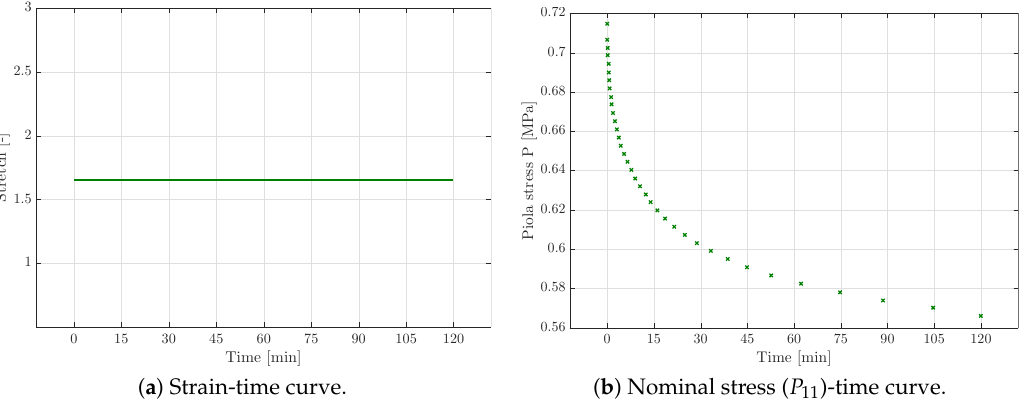
Figure 3. Relaxation test results of the micro-testing machine, where the stretch level is fixed ( a ) in order to get the nominal stress decrease over time ( b ).